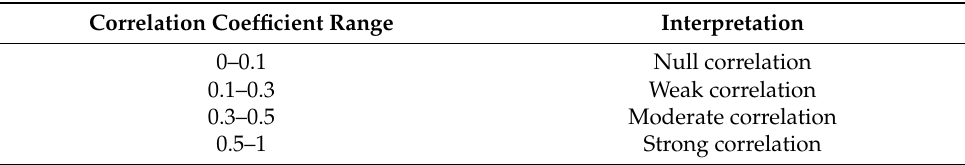
Table 2. Cohen scale